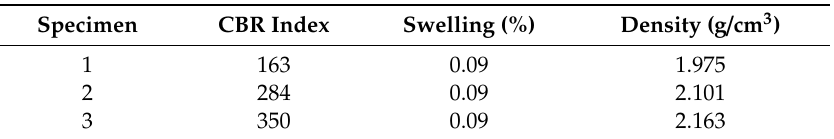
Table 4. Summary CBR test